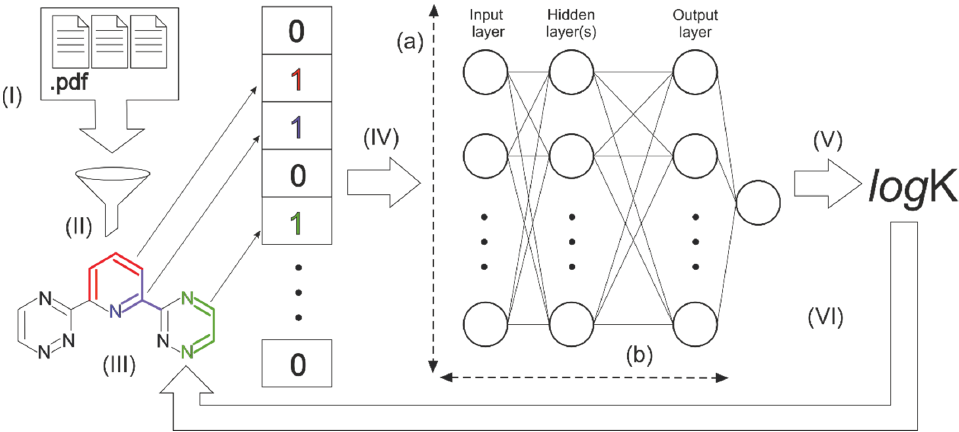
Figure 1. The general scheme of the investigation